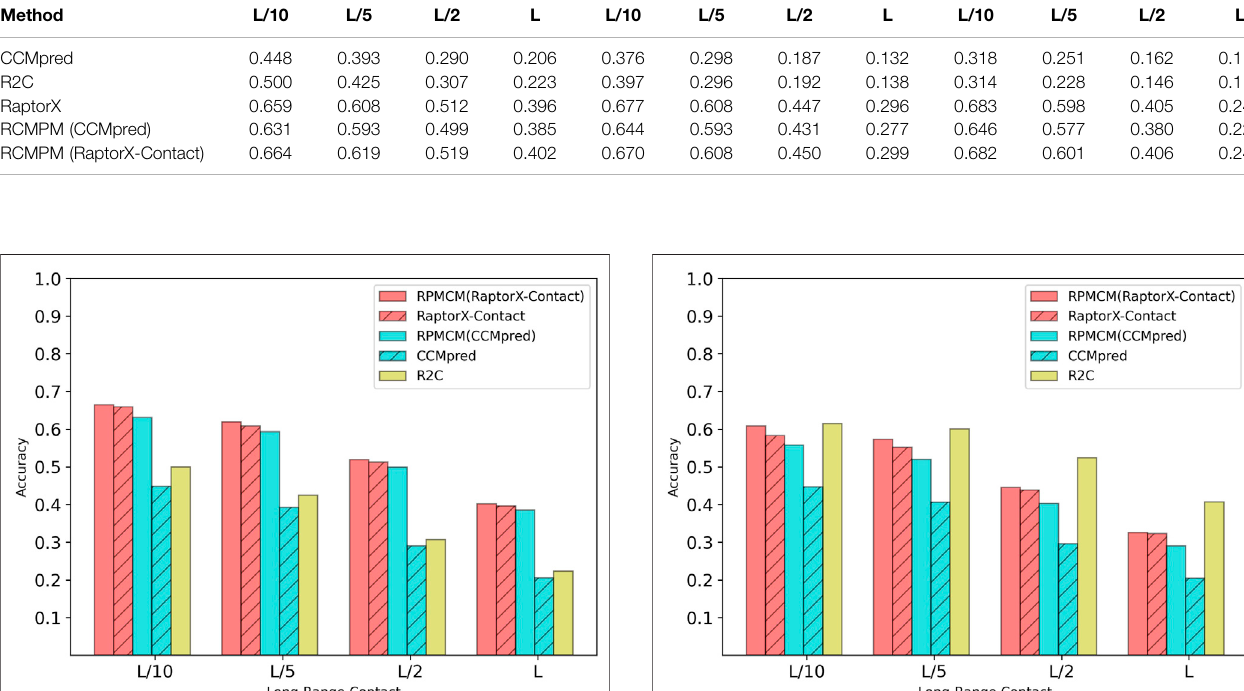
TABLE 3 | Contact map results by four different methods on the CASP11 testing dataset. Long-range Medium-range Short-range